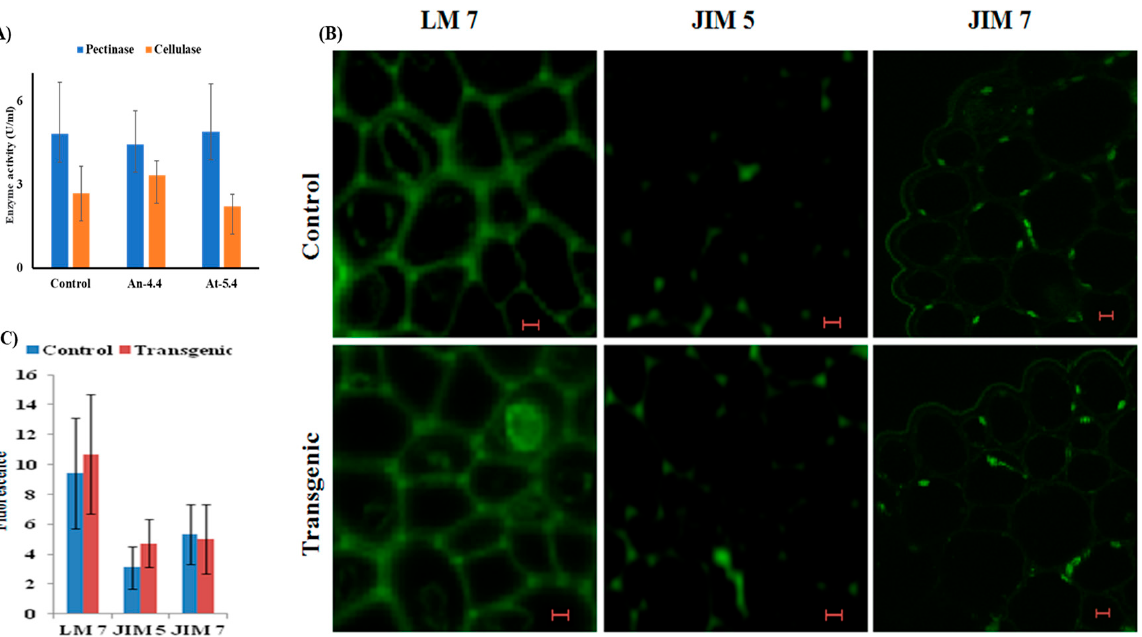
Figure 6. Biochemical characterization of cell wall. ( A ) Graph showing average values ( n = 6) of pectinase and cellulase enzyme activity in control and both transgenic lines (An-4.4 and At-5.4). ( B ) Representative confocal images showing transverse section of transgenic (An-4.4) and control leaves at 40 × magnification. Leaf sections were stained with fluorescence labelled pectin specific monoclonal antibodies (LM 7, JIM 5, JIM 7). ( C ) Graph representing average fluorescence values ( n = 5) in the transgenic (An-4.4) and control leaves.